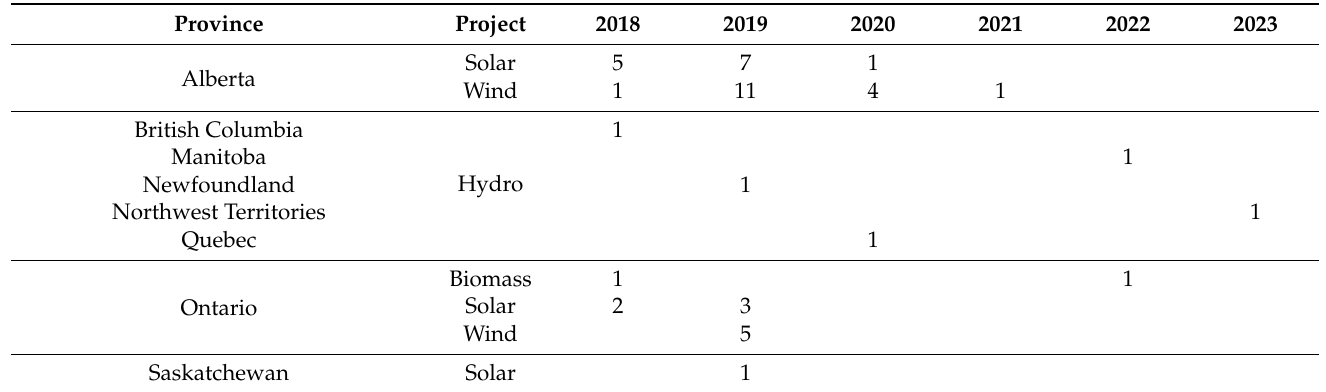
Table 2. In-development renewable energy projects between 2018 and 2023 [88].